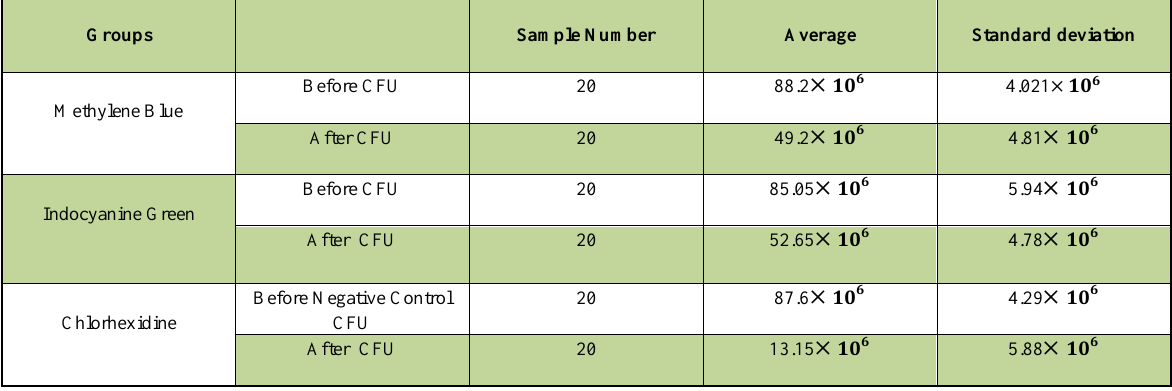
Table 1: Central distribution indexes and standard deviation of Staphylococcus Aureus colony count in a different group. Groups